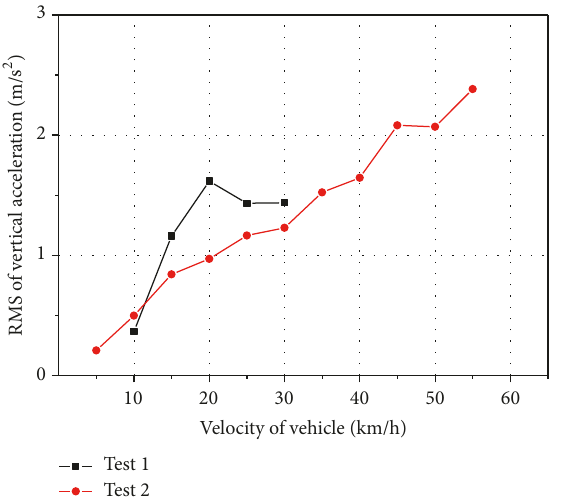
Figure 13: The comparison of the two test